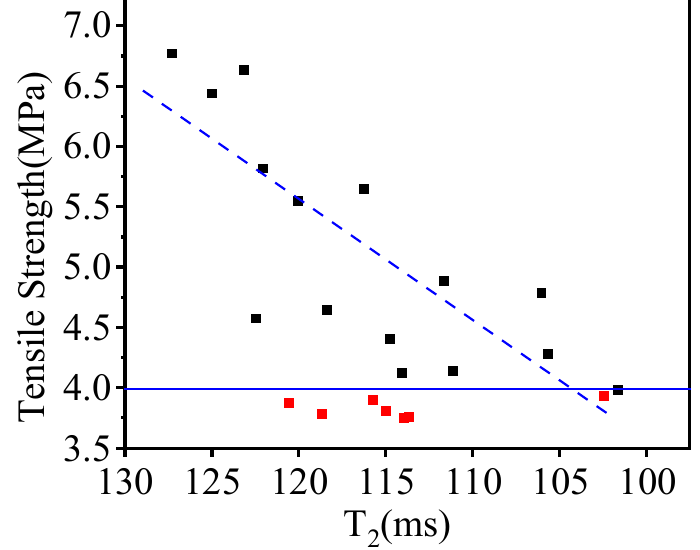
Figure 11. Variation of tensile strength of samples, with T 2 .